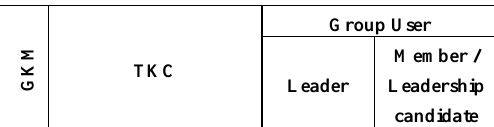
the group. Table 10, table the key storage cost for HGKM, LKH, and OFT. Table 1. The key storage cost for HGKM, LKH, and